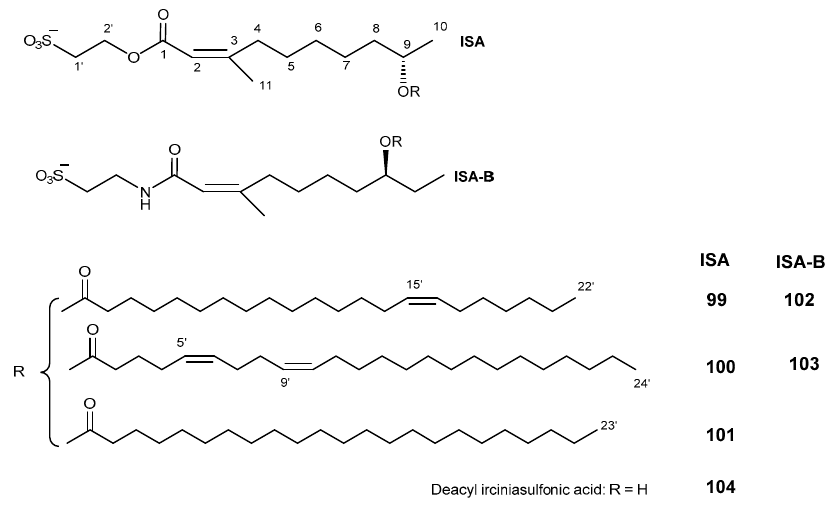
Figure 21. Structure of ISA ( 99 – 101 ), ISA-B ( 102 , 103 ), and deacyl ISA ( 104 ).